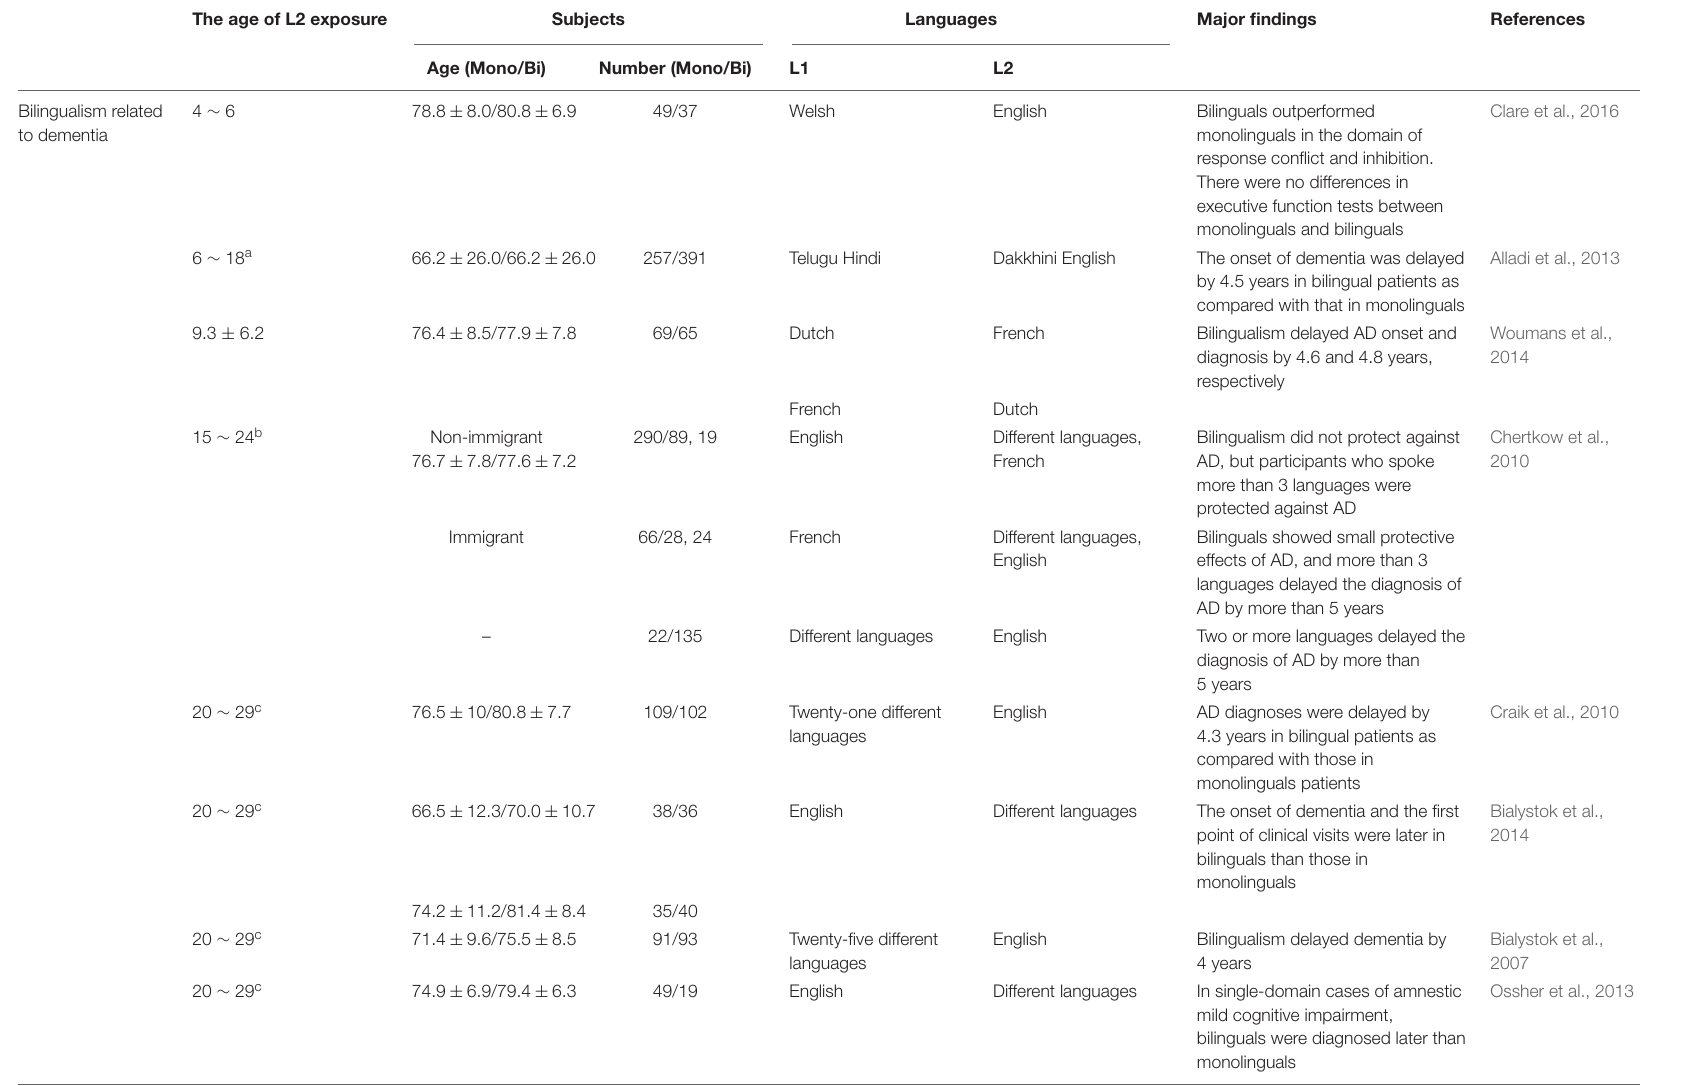
TABLE 1 | The studies associating bilingualism to reduced incidence of dementia. The age of L2 exposure